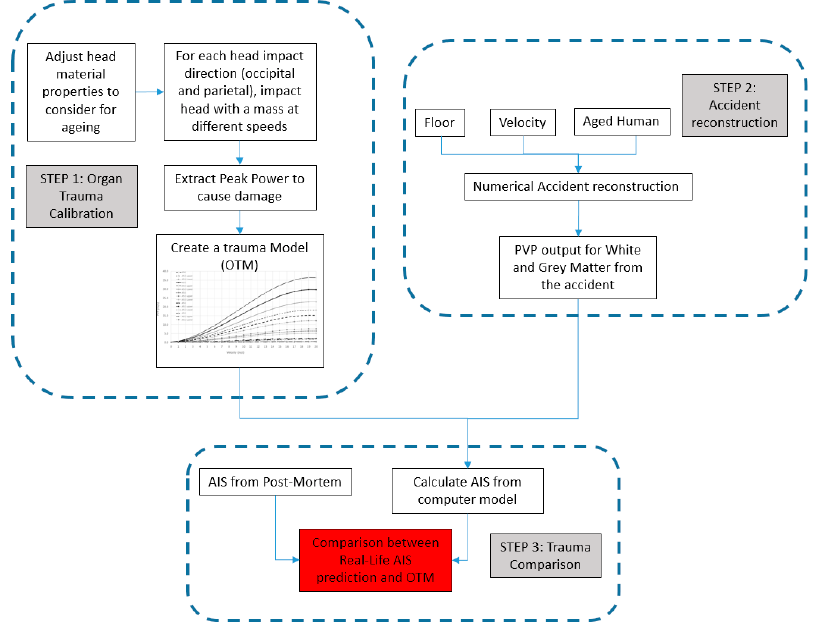
Figure 7. Methodology Flowchart.